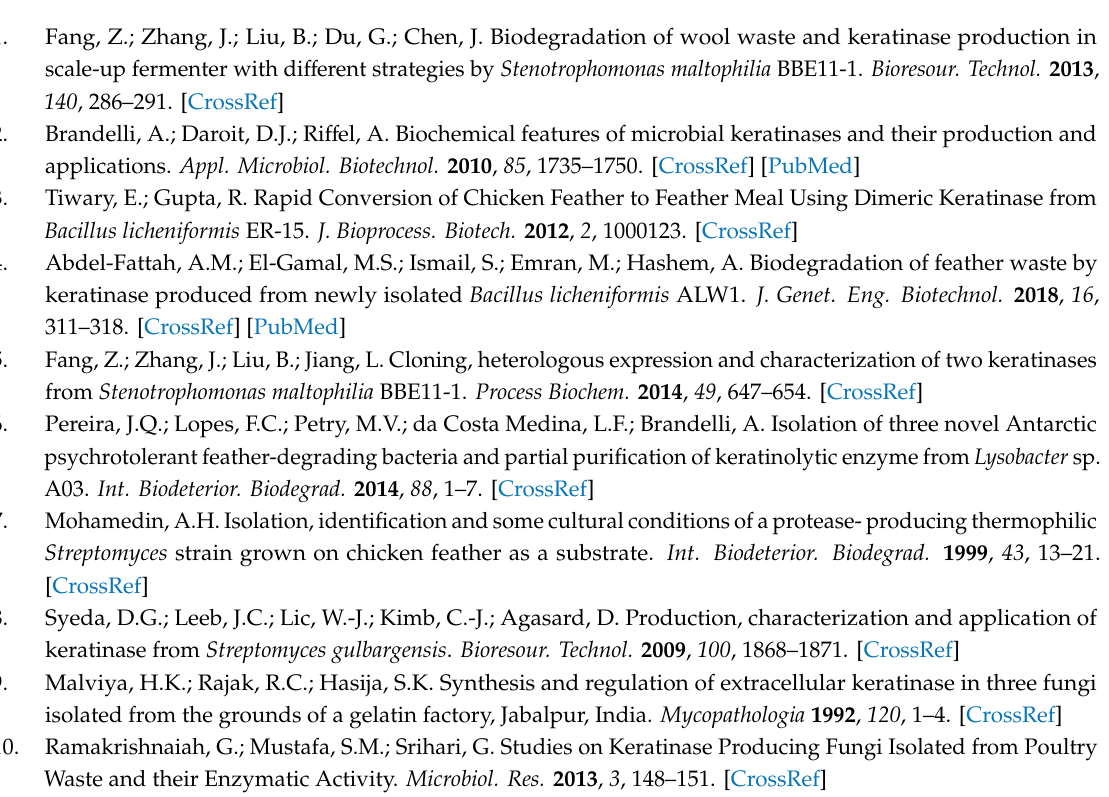
Figure S1: Azokeratin formation from feather keratin treated with the azotization of sulfanilic acid. Figure S2: Model diagnostic plots; (a) predicted versus actual, (b) studentized residue versus predicted, (c) normal plots of residue and (d) outlier T versus